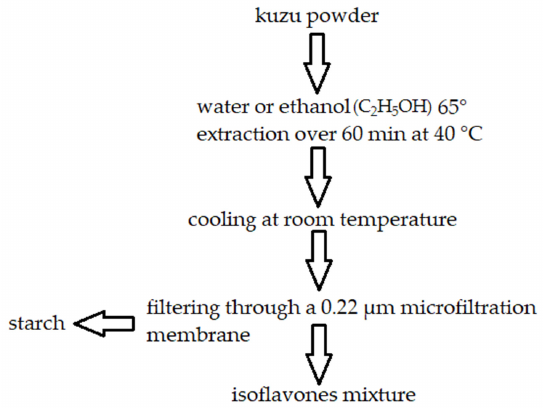
Figure 2. Extraction of kuzu starch and isoflavones. In this method, starch is a by-product. Own figure based on Ref. [64]. 2022, Mocan et al. The kuzu starch composition has been presented in Table 3.